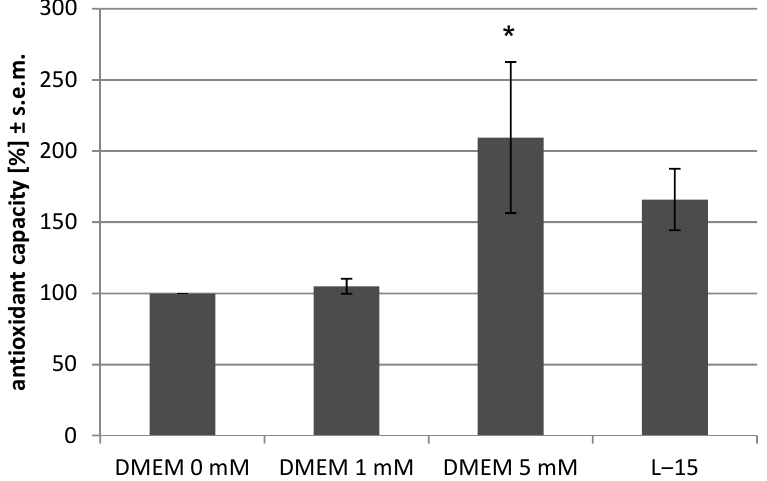
Figure 6. Antioxidant capacity of DMEM (containing 0 mM, 1 mM or 5 mM pyruvate) and L-15 medium (containing 5 mM pyruvate). The values of DMEM 0 mM were set as 100% ( n = 4). In addition, we cultured the two mammalian and three piscine cell lines in DMEM without pyruvate. Omitting the pyruvate from the medium did not alter the general viability of the cells (data not shown). However, the viability was in part significantly impaired when the cells were stimulated with plasma-treated pyruvate-free medium (Figure 7). A treatment time of only 60 s of pyruvate-free DMEM significantly reduced the viability of OMYleb and OMYsd cells compared with 60-s treatment of DMEM containing pyruvate. By contrast, the measured viability of the other cells (RTgill-W1, mHep-R1 and HepG2) was unchanged in pyruvate-free PAM compared with PAM containing